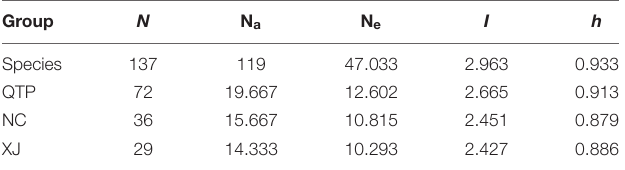
TABLE 2 | Genetic diversity of Elymus sibiricus estimated by